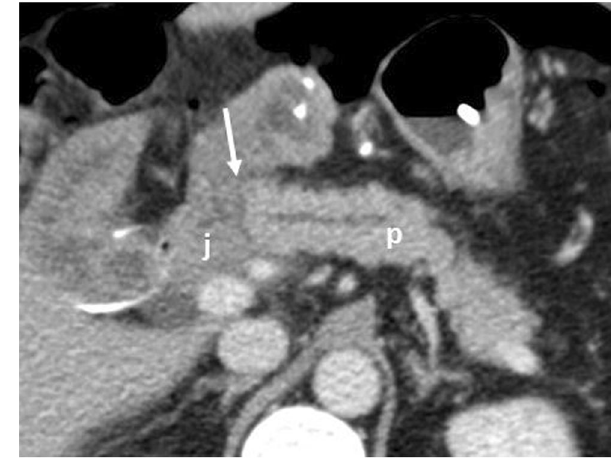
Fig. 4 Central pancreatectomy. The head of the pancreas (ph) and the pancreatic tail (pt) are visible. The pancreaticojejunostomy to the distal pancreatic remnant (white arrow) and the anastomotic jejuna loop (j) are visible